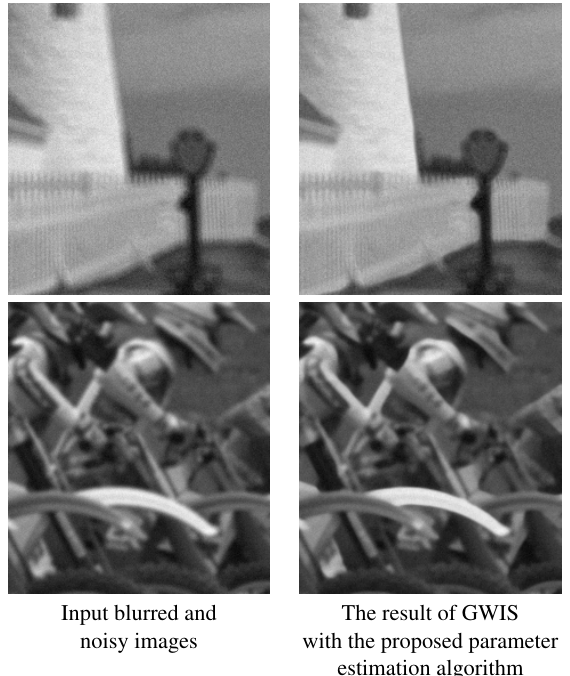
Figure 7. A visualization of the importance measure of image patches. Darker areas are considered as more important.